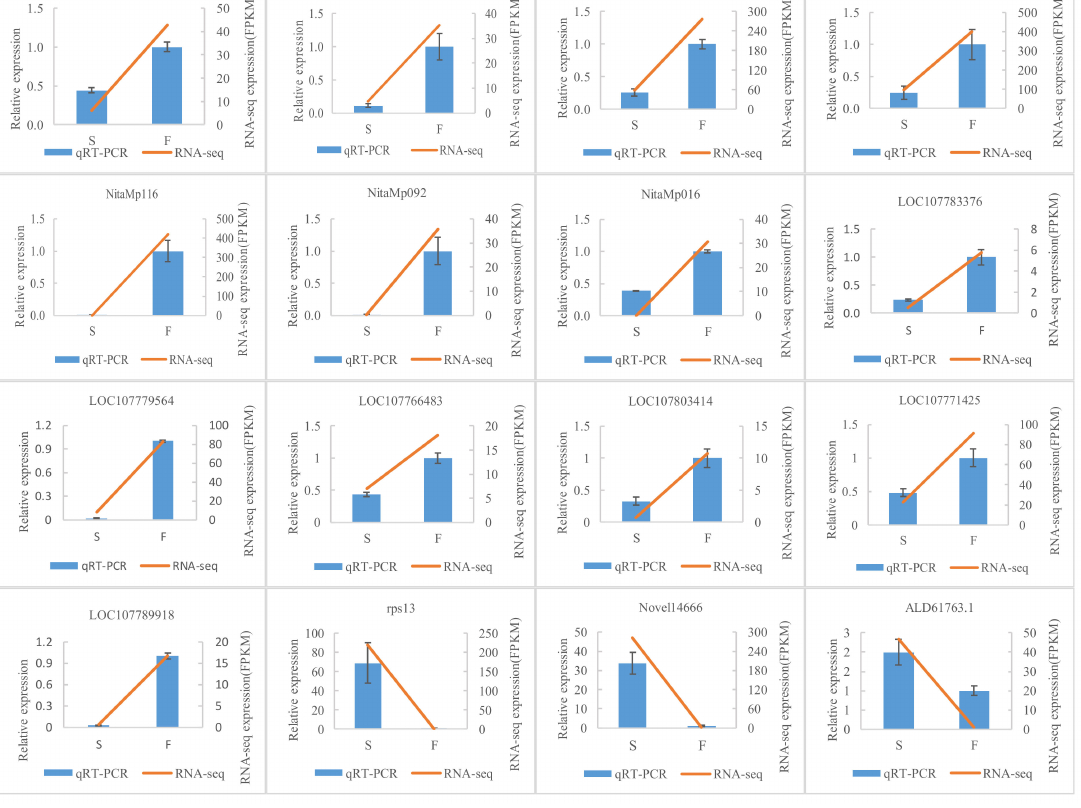
Figure 3. qRT-PCR verification diagram between flower buds of msZY and ZY. Comparison of the expression levels determined by qRT-PCR and RNA-seq from three biological replicates. Result were calculated using log2 fold variation measurements. All data indicate mean ± standard error (SE). LOC107786145, LHY-like(late elongated hypocotyl) protein; LOC107775222, LHY-like protein; LOC107768506, 70 kDa protein 2-likeheat shock cognate; LOC107766295, 70 kDa protein 2-likeheat shock cognate; NitaMp116,hypothetical protein, similar to orf124 in Beta vulgaris ; NitaMp092 and orf306, hypothetical proteins; NitaMp016, hypothetical protein; LOC107783376, 70 kDa protein